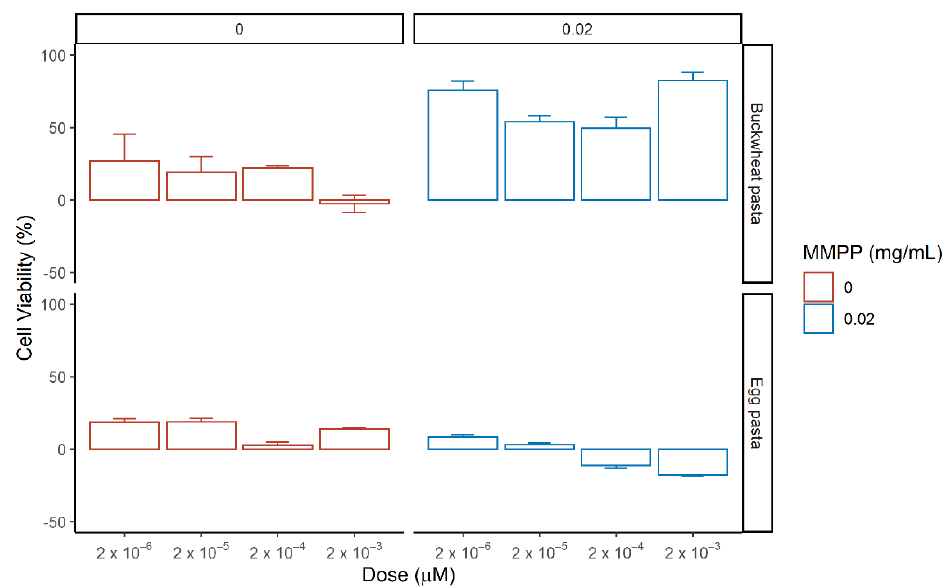
Figure 7. Effect of the pasta-derived carotenoid-enriched fractions on the cell viability of Madin– Darby canine kidney (MDCK) in the absence (left, red) or presence (right, blue) of MMPP after 24 h incubation. Reported values correspond to mean of the difference in cell viability between tested phytocomplexes and reference (medium in red, and MMPP in blue) with standard error over three biological replicates. The percentage of cell viability was calculated using the ratio Abs TEST /Abs CTRL .